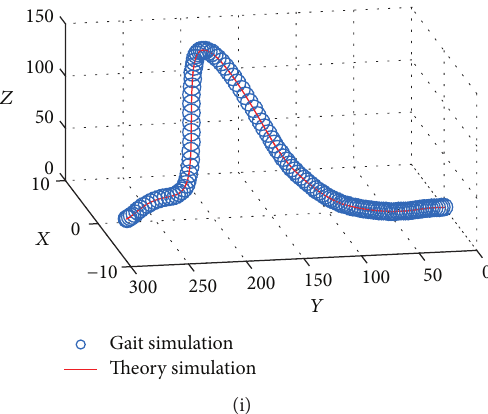
Figure8:(a–i)representthetrajectoryofthefoottrajectorybasedongaitresultswithrespecttothetrajectoryoftherobotduringperformance of the exercise. The outer circles show the trajectory of the foot measured in the gait lab and the inner line represents the trajectory of the robot during performance of the exercise.